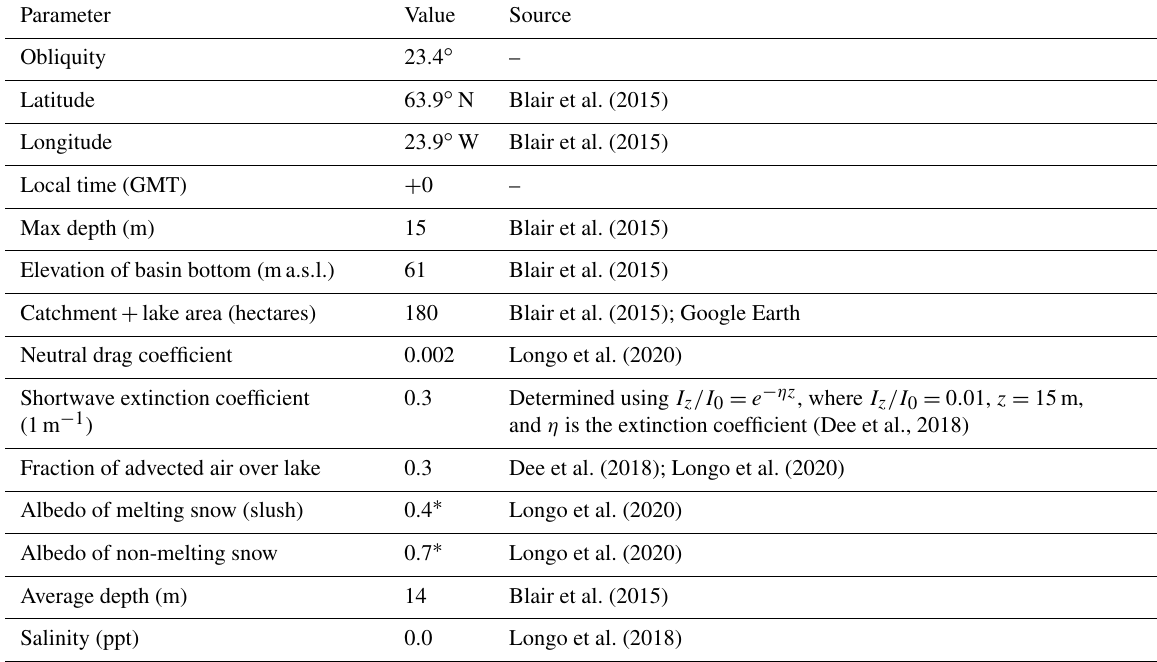
Table A1. Lake-specific parameters for the model setup and references used to constrain the parameters.